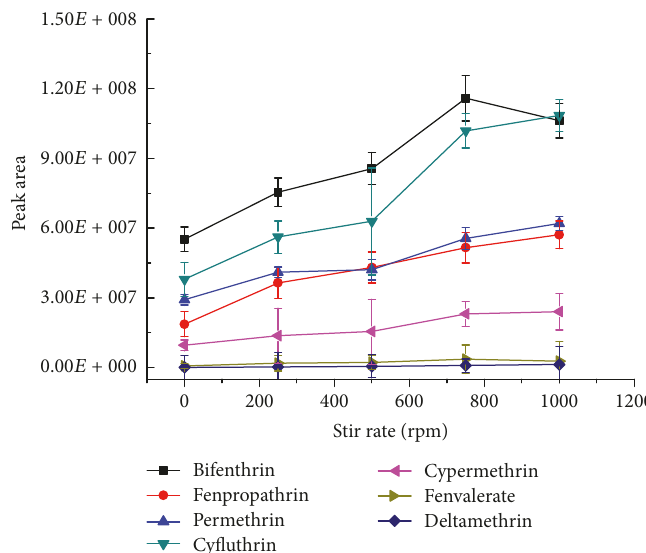
Figure 4: The effect of the stirring rate on the extraction efficiency ( 𝑛 = 3 ). The standard mixture concentration: 20 ngmL −1 , extraction time: 20 min, desorption temperature: 280 ∘ C, and desorption time: 5 min.